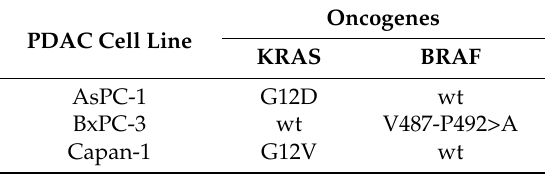
Table 1. Mutational status of pancreatic ductal adenocarcinoma (PDAC) critical genes [21,22]. PDAC Cell